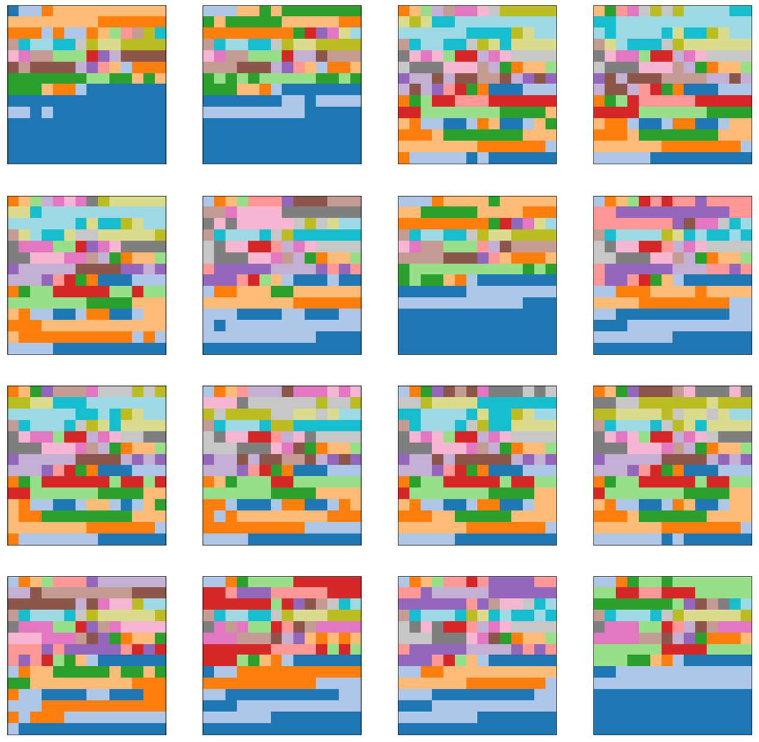
Figure 8. 2D spectral feature maps of 16 classes in the Salinas dataset.